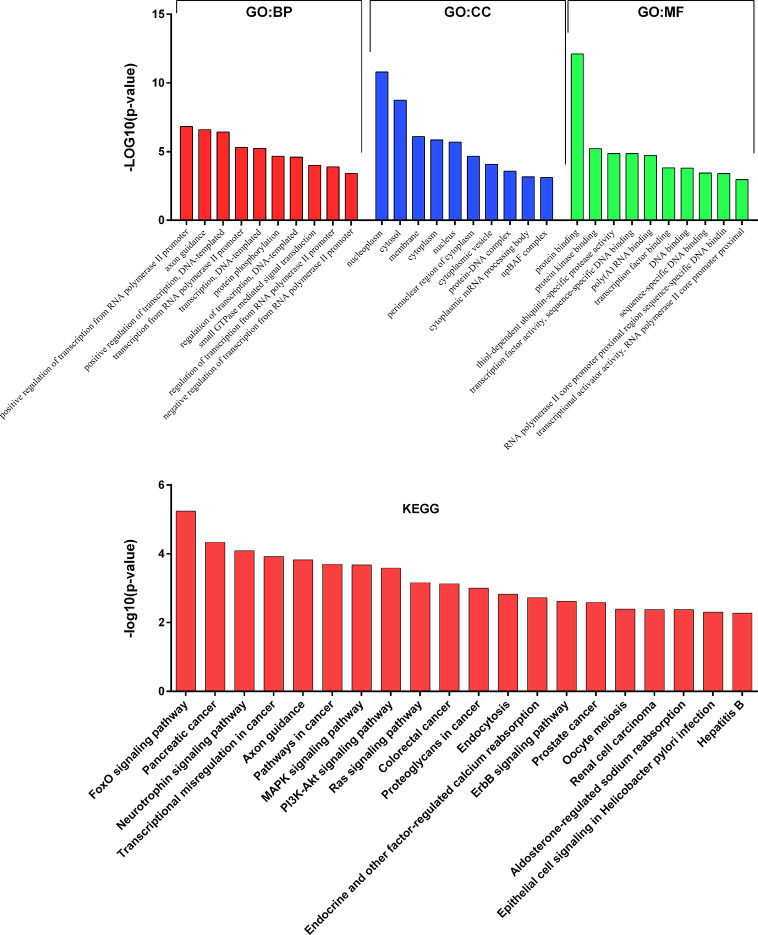
Results of GO and KEGG pathways annotation analysis of the predicted genes targeted by the six prognostic microRNAs.